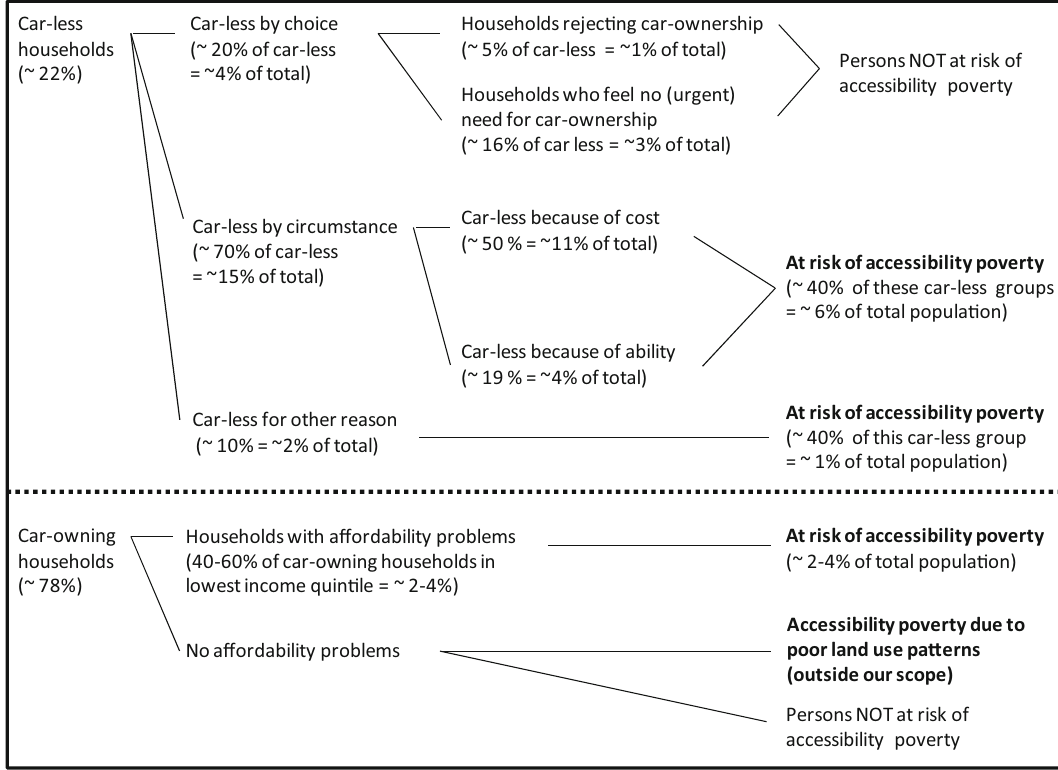
Fig. 1 Tree-like estimate of the share of households at risk of accessibility